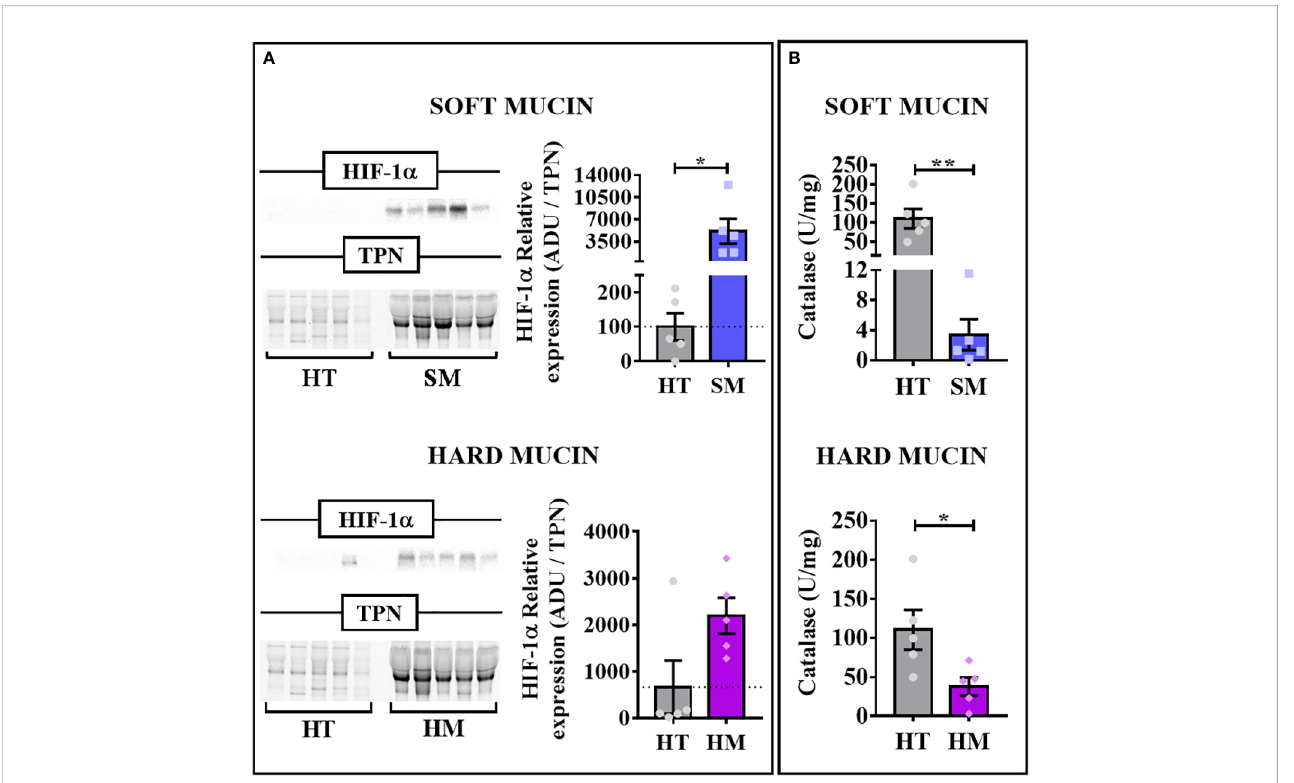
FIGURE 2 Cellular hypoxia and oxidative stress markers in PMP samples. (A) HIF-1 a relative protein expression levels in soft (SM; n=5) and hard mucin (HM; n=5) compared with healthy tissues (HT; n=5; non-tumoral appendix and colon tissues) evaluated by Western Blot. The arbitrary densitometric unit (ADU) for the protein was normalized by the Total Protein Normalization (TPN) value. (B) Catalase activity (U/mg) in soft and hard mucin (n=5) compared to healthy control tissues (n=5; non-tumoral appendix and colon tissues) evaluated by enzymatic assay. Unpaired t test or Mann-Whitney test was used based on Kolmogorov-Smirnov normality test. * p < 0.05, ** p <